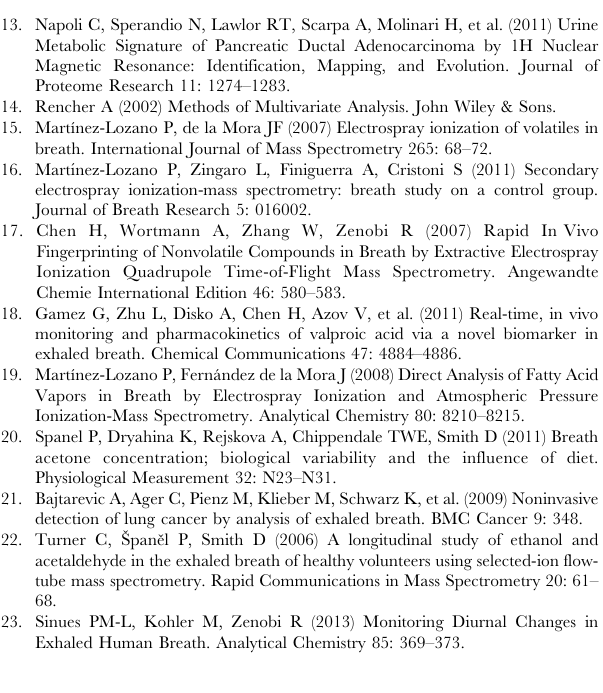
Figure S2 Clustergram resulting from hierarchical cluster analysis for the 10 Kruskal-Wallis/PCA/CA dimensions (rows).